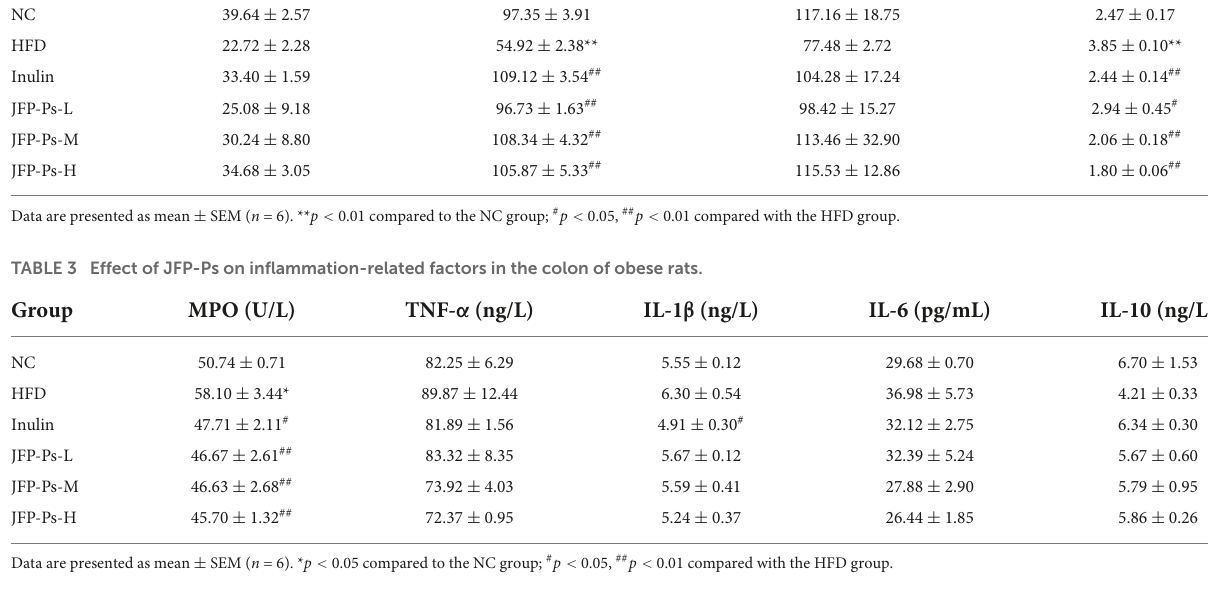
TABLE 2 Effect of JFP-Ps on antioxidant activities in the colon of obese rats. Group SOD (U/mL)